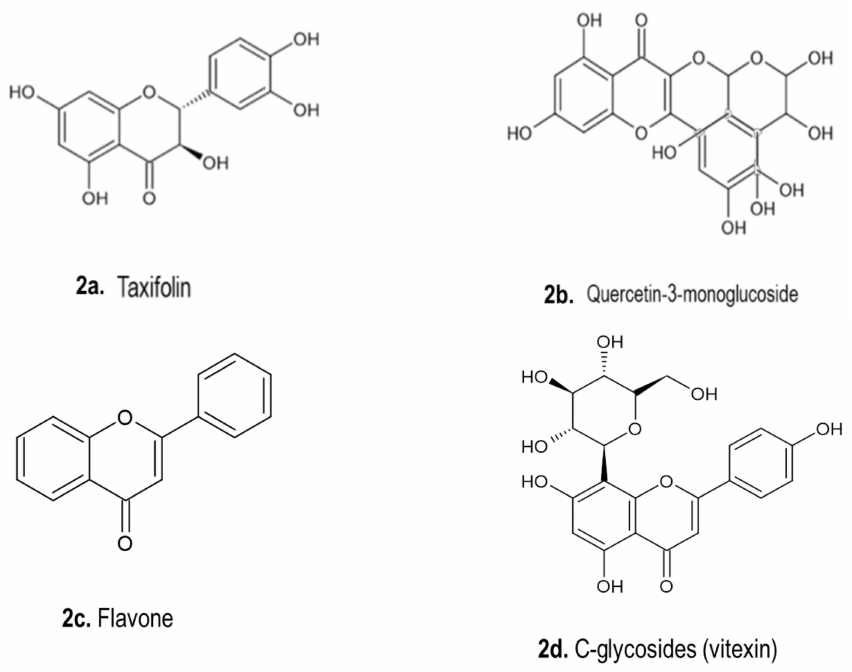
Figure 2. Chemical structures of phenolic compounds isolated from Drimia spp. [1]. ( a ). Taxifolin (Type of flavonoid, C 15 H 12 O 7 ); ( b ). Quercetin-3-monoglucoside (C 21 H 19 O 12 ); ( c ). Flavone (C 15 H 10 O 2 ) and ( d ) Vitexin (Type of flavone glycosides, C 21 H 20 O 10